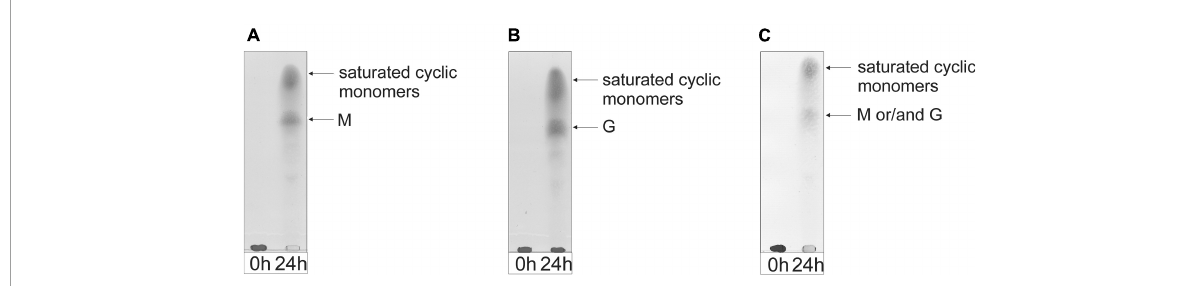
FIGURE7 TLC analysis of the saccharide mixtures generated after a 24-h incubation of (A) M-block alginate, (B) G-block alginate, and (C) low-viscosity M. pyrifera alginate with the AlyRm4